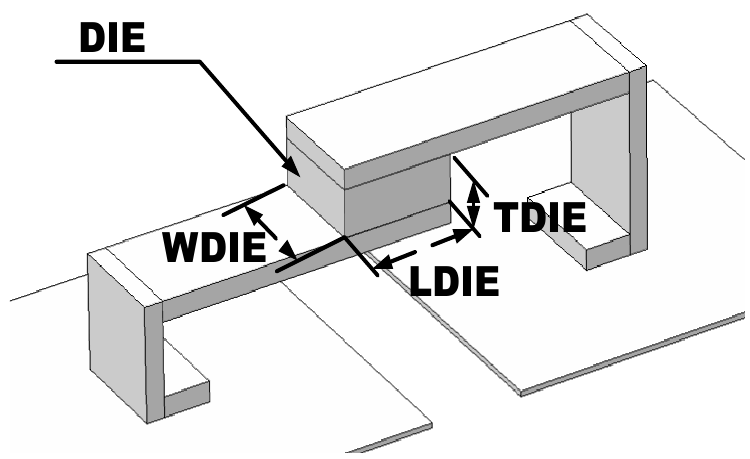
Figure 4. Initial Model Geometry.